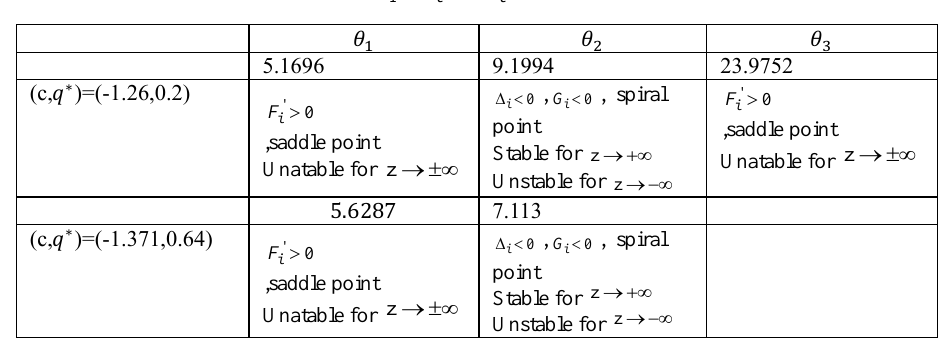
Table 1. Types of equilibrium points and their stability when model parameters are given,